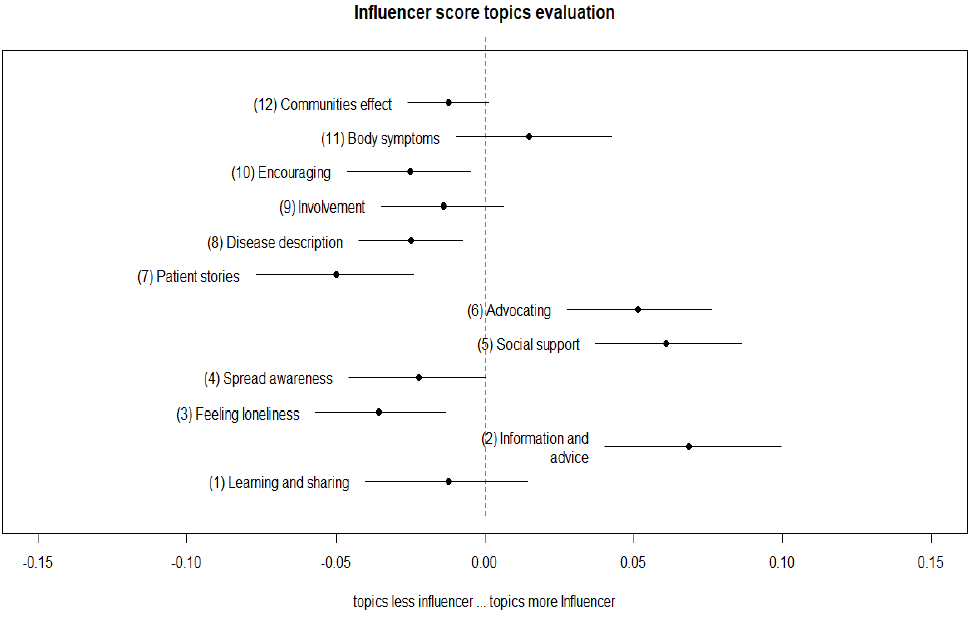
Figure 4. Estimated topic proportion to be discussed by influencer score.